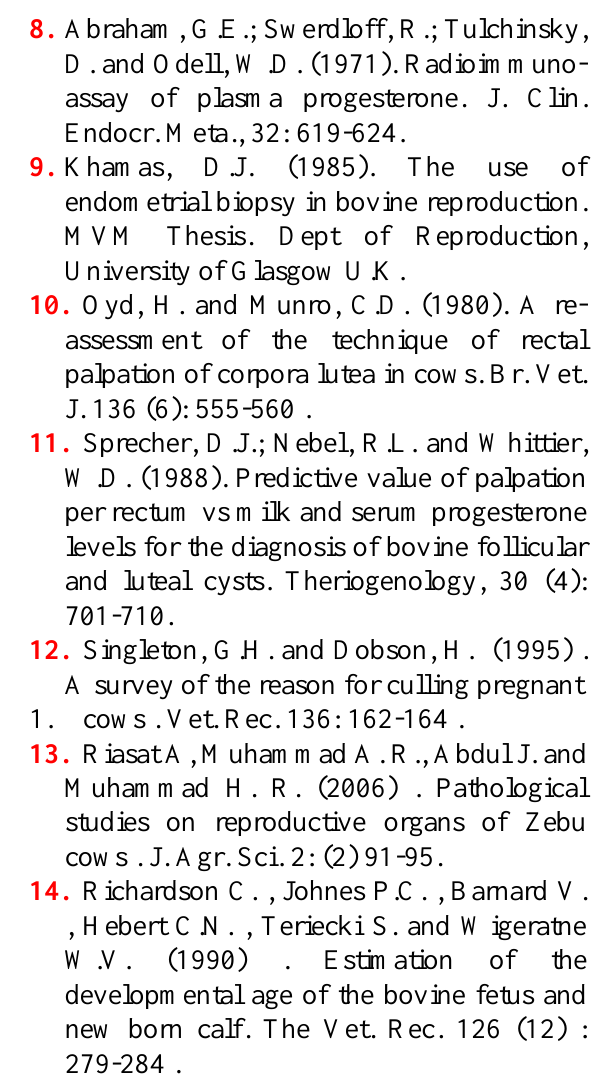
Table, 5: A comparative aspects of hormonal levels with the ovarian structures examined grossly . Ovarian structures Pregnancy with functional CL (18) Pregnant Non-pregnant with functional CL (16) Non-pregnant with out functional CL (16) case Pathological conditions : Follicular cysts on both ovaries 4 case Follicular cyst on R.O. 3 cases Follicular cyst on L.O. 1 case S.D. =